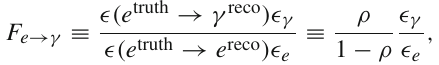
The electron-to-photon fake-rate is defined as the ratio